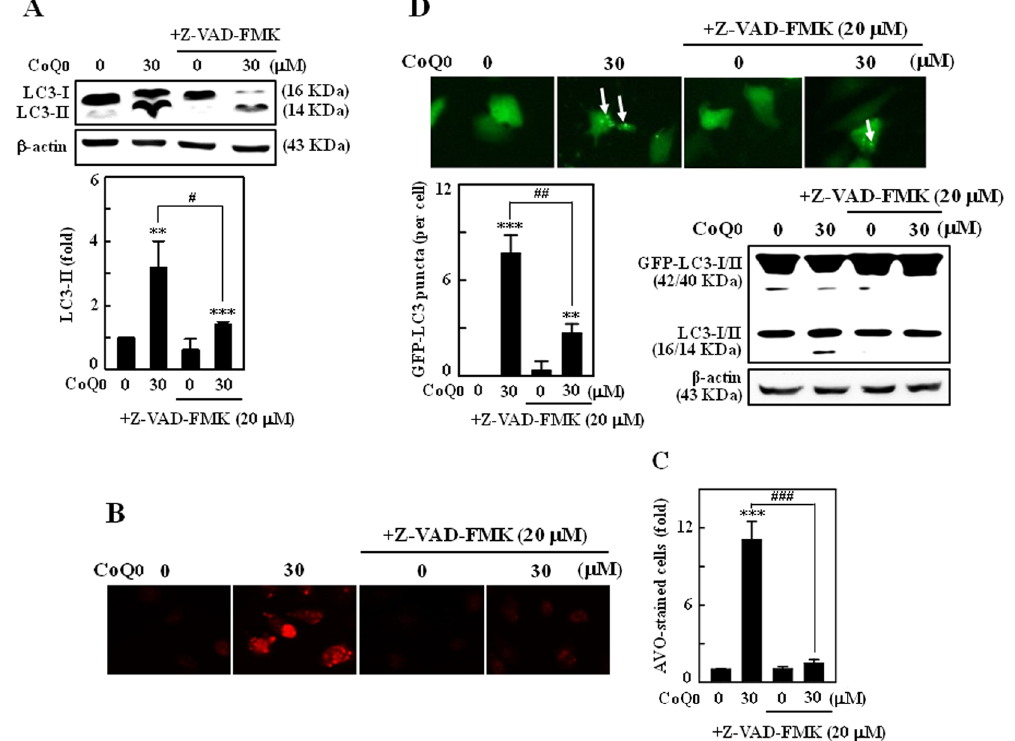
Figure 8. Inhibition of apoptosis suppressed CoQ 0 -induced autophagy in SKOV-3 cells. ( A–C ) Cells were pretreated with caspase inhibitor (Z-VAD-FMK, 20 μ M) for 1 h, and then incubated with CoQ 0 (30 µ M) for 24 h. (A) LC3-I/II was determined using Western blot, and relative changes in protein intensities were quantified using commercially available software. (B) Formation of AVOs was visualized under a red filter fluorescence microscope (100 × magnification) using AO stain. (C) Number of AO stained cells with CoQ 0 or Z-VAD-FMK treatment was presented as histogram, control being as 1.0 fold. (D) Cells were transfected with GFP-LC3 expression vector for 24 h before Z-VAD-FMK and CoQ 0 treatment. GFP-LC3 dots in cells were observed under a confocal microscope (200 × magnification). Conversions of GFP-LC3 and endogenous LC3 were determined by Western blot. Results expressed as mean ± SD of three independent assays (n = 3). Significant at ** p < 0.01; *** p < 0.001 compared with untreated control, and significant at # p < 0.05; ## p < 0.01; ### p < 0.001 compared with CoQ 0 alone treated